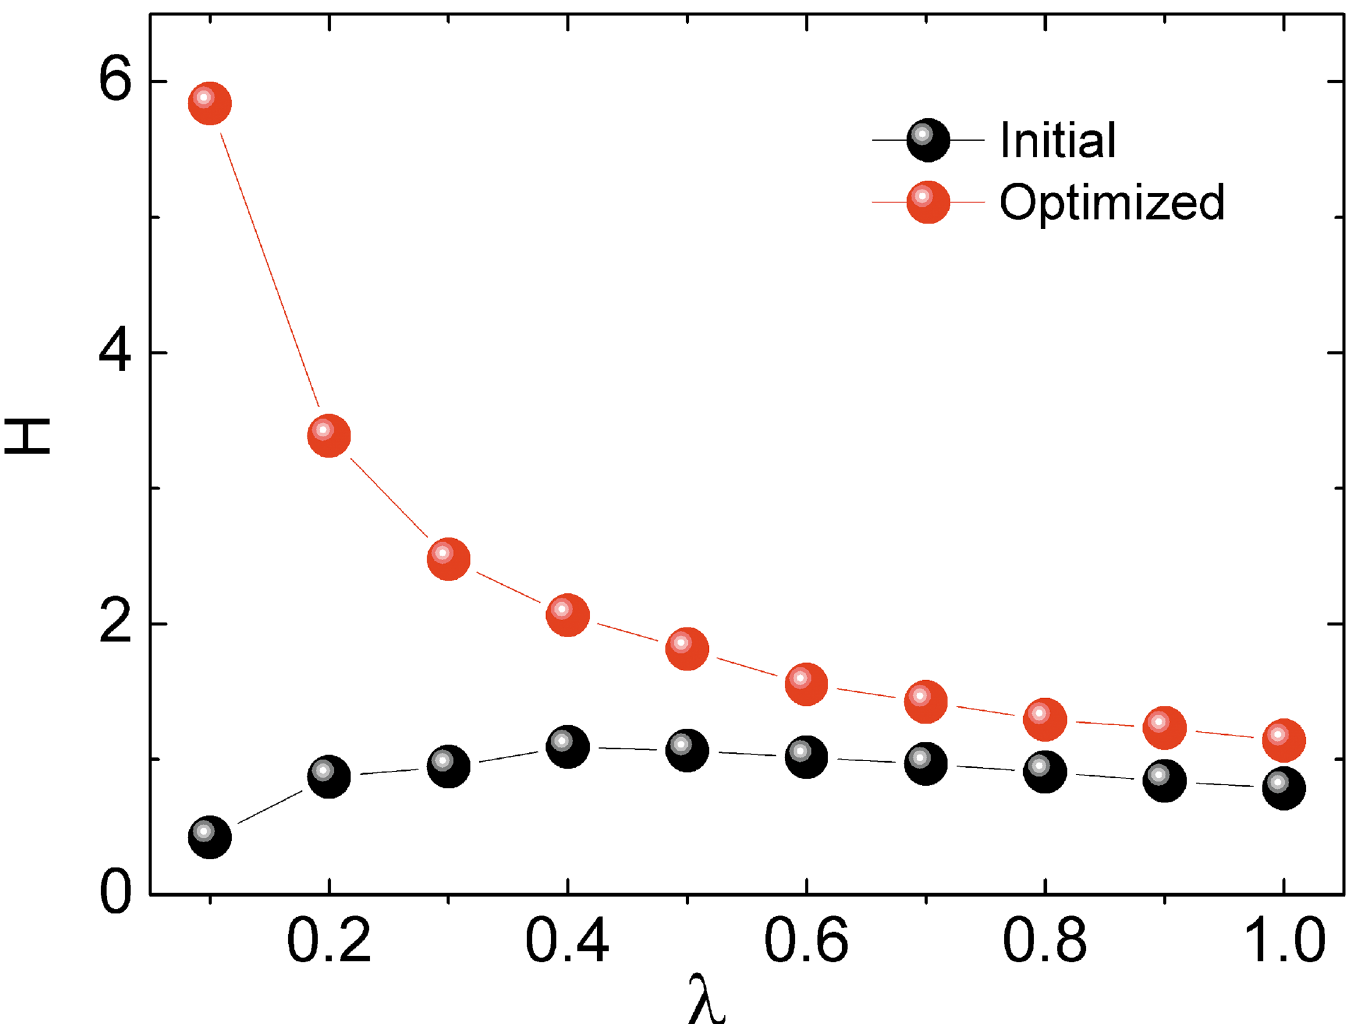
Fig 2. The cost-efficiency indicator H of different maximum costs. Each point is averaged from 20 different networks. The adjusting parameter is set to ω = 0.8. The algorithm runs for 1,000 iterations each